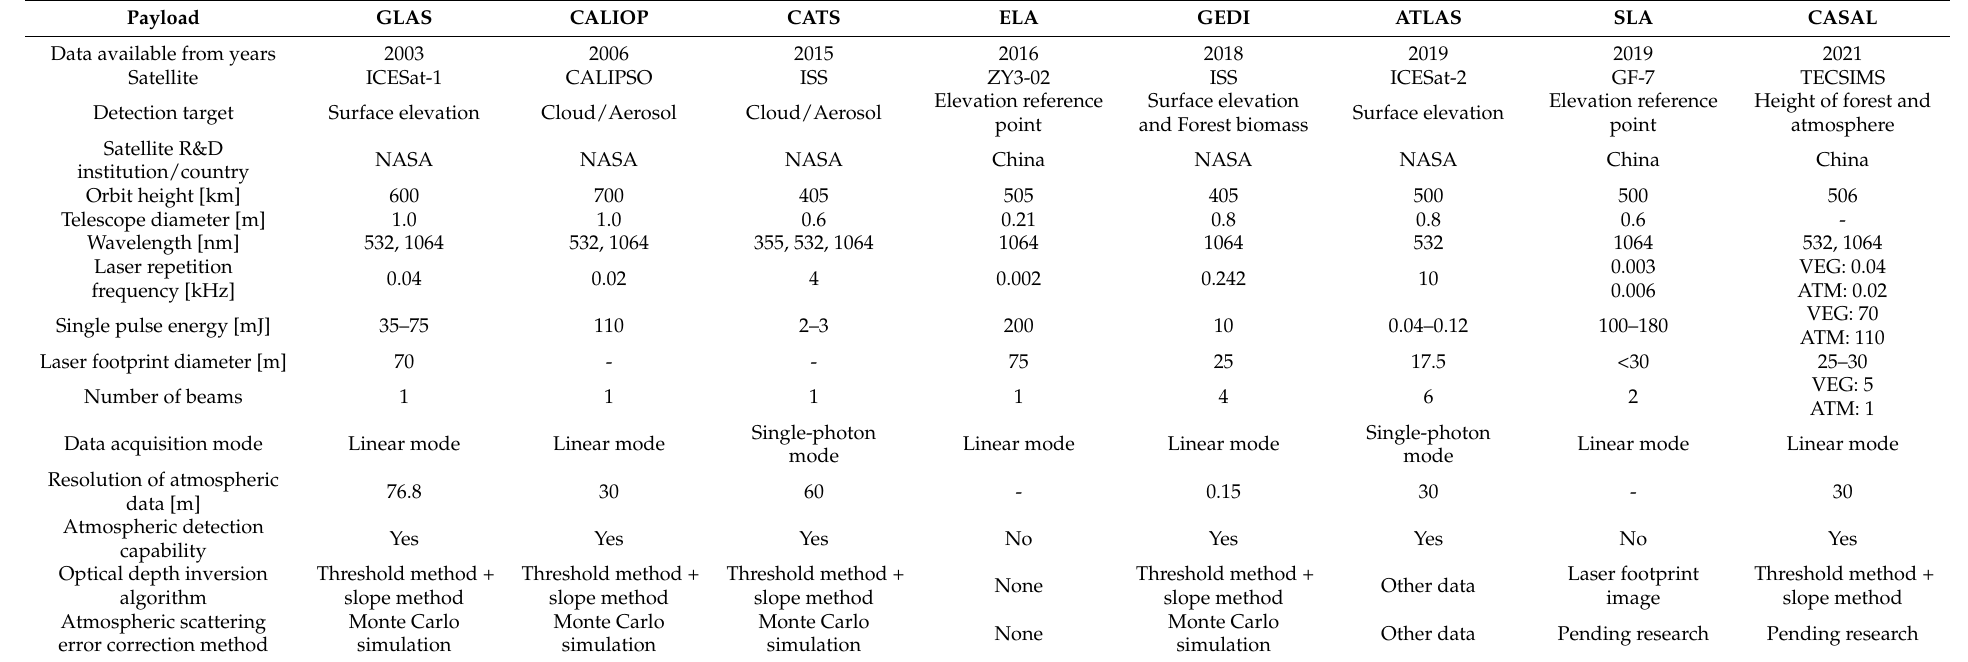
Table 2. Technical parameters of different laser altimetry